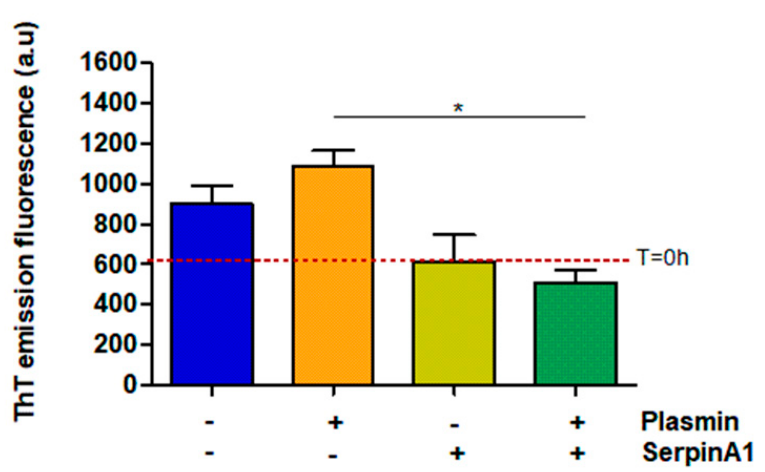
Figure 3. Transthyretin amyloid formation is favored upon plasmin-mediated proteolysis, being partially inhibited by SerpinA1. Thioflavin T experiments were performed upon transthyretin V30M incubation with plasmin and/or SerpinA1, at 37 °C for 24h. The fluorescence emission signal of thioflavin T of transthyretin V30M at the beginning of the experiment (T = 0 h) is represented as the red dotted line around 607. The data results from three independent in vitro experiments ( n = 3). Statistical analysis was performed using one-way ANOVA with Tukey’s multiple comparison as post-test. * p < 0.05 in the presence of plasmin/presence of SerpinA1 vs. presence of plasmin/absence of SerpinA1, q = 6.092, df = 3. Effect size (r) = 0.924, odds ratio = 0.69 for an interval of confidence of 95%.